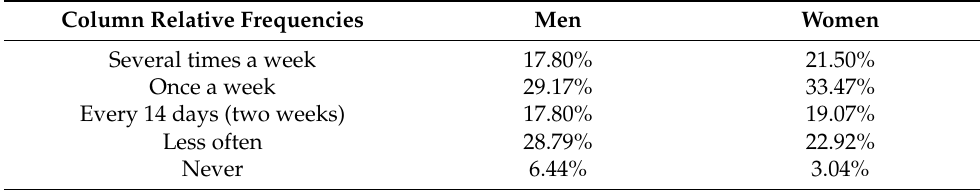
Table 6. Contingency table, Hypermarkets & Respondent’s gender.